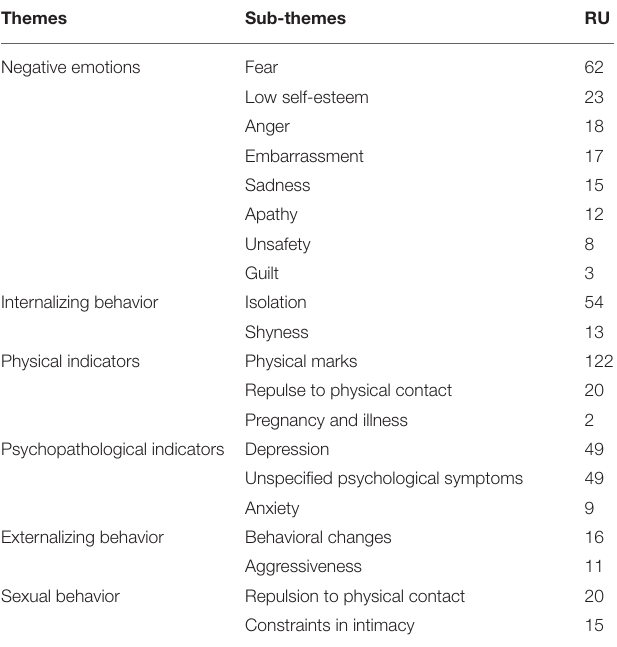
TABLE 4 | “Victimization Signs” dimension’s themes and